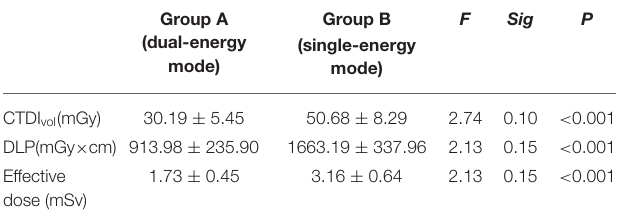
TABLE 3 | Radiation dose values.